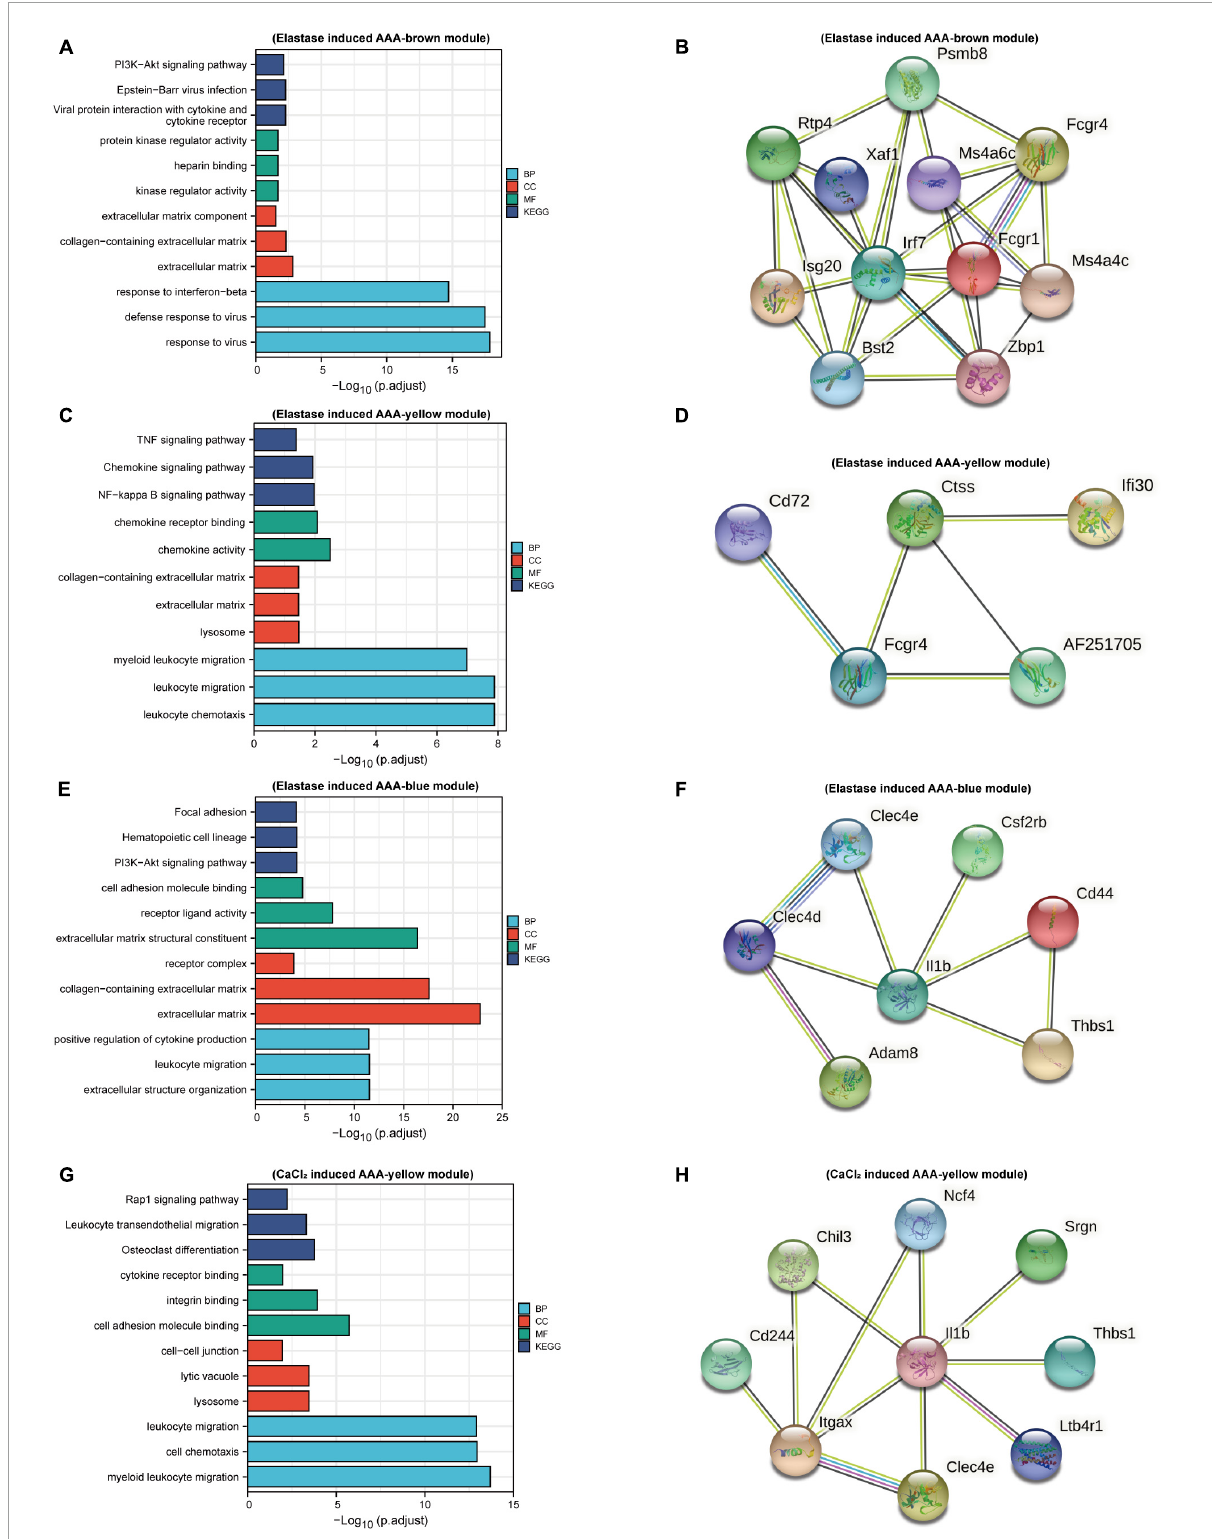
FIGURE3 Function enrichment and PPI analysis. Bar plots of GO and KEGG function enrichment results for genes in brown module (A) , yellow module (C) , and blue module (E) of peri-adventitial elastase incubation induced AAA dataset (GSE152583) and genes in blue module (G) of CaCl 2 induced AAA dataset (GSE164678). PPI network for hub genes in brown module (B) , yellow module (D) , and blue module (F) of elastase induced AAA dataset and for hub genes in blue module (H) of CaCl 2 induced AAA